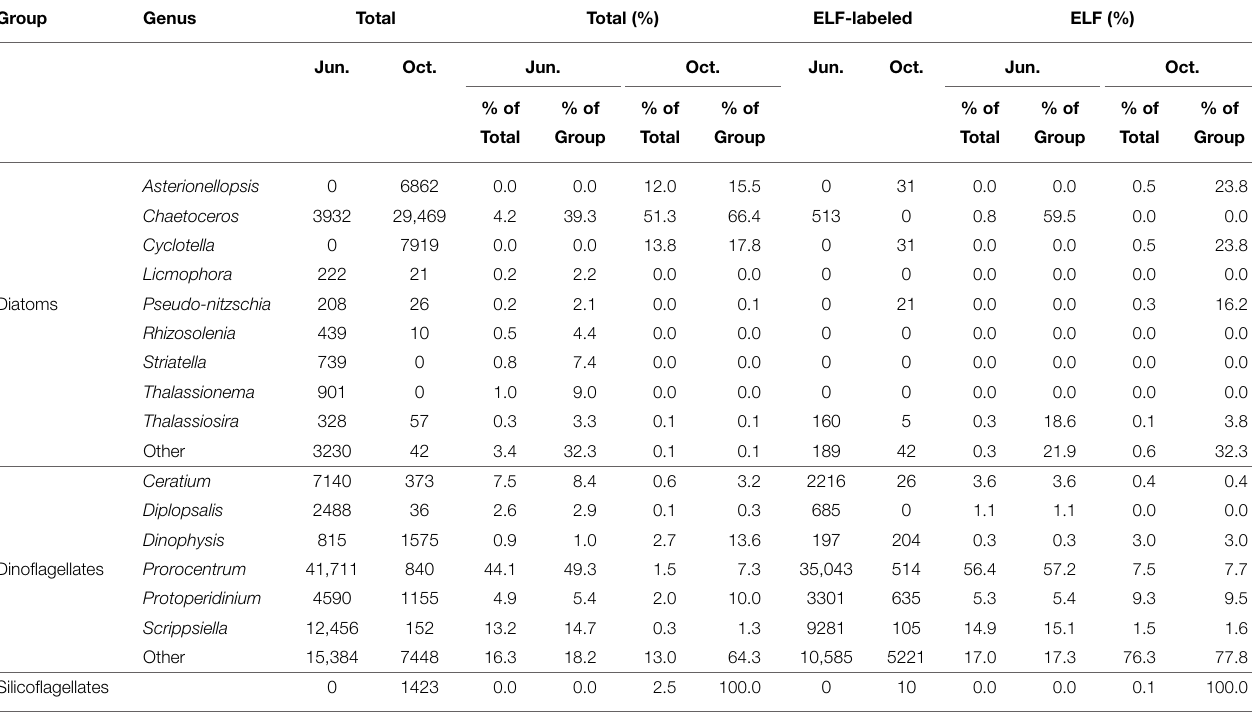
TABLE 1 | Total cell abundance and cells expressing ELF (cells l − 1 ) for main phytoplankton taxa over the 15 stations during June and October surveys.